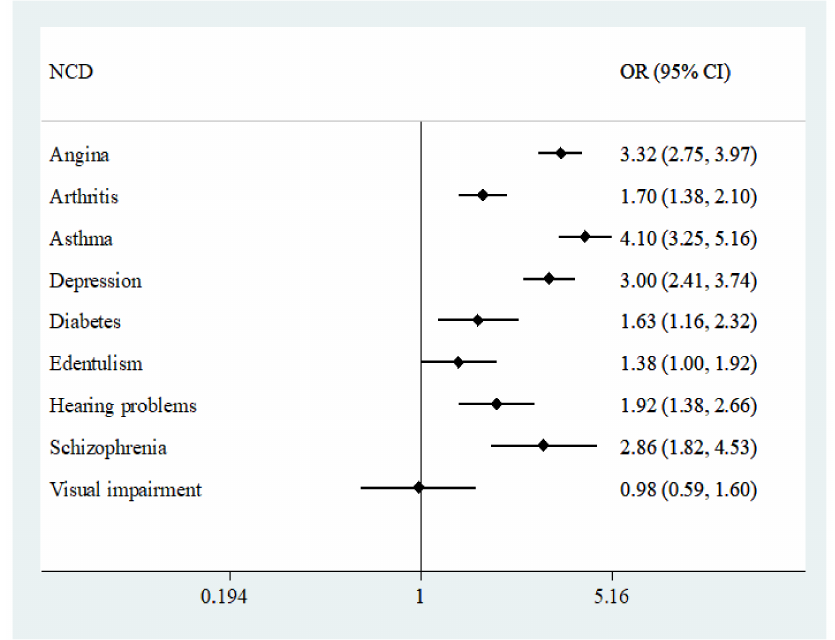
Figure 1. Association between non-communicable diseases and tuberculosis estimated. by multivariable logistic regression. Abbreviation: NCD Non-communicable disease; OR Odds ratio; CI Confidence interval. Models are adjusted for age, sex, wealth, education, smoking, heavy drinking, and